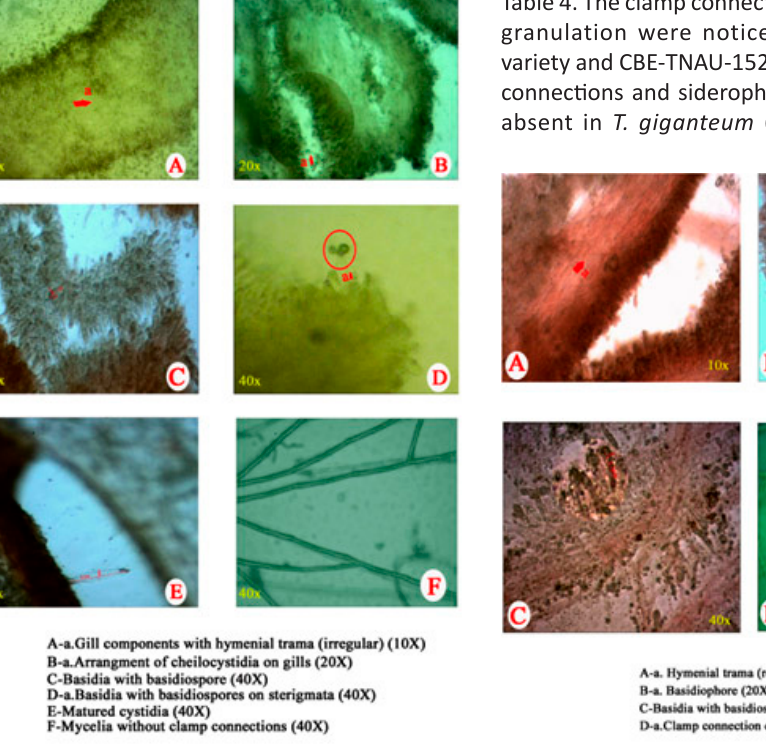
Fig. 3c. Microscopic observation of Tricholoma giganteum (Massee) (CBE-TNAU-1519)